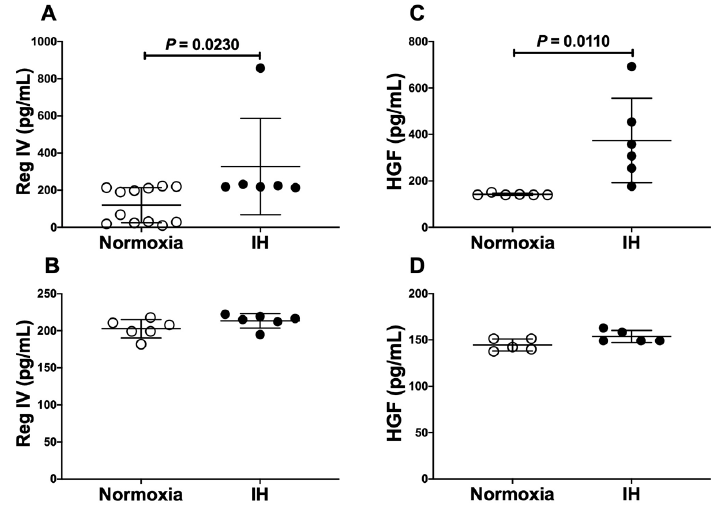
Figure 10. The effects of miR-499 mimic transfection on Reg IV and Hgf expression. Concentrations of medium Reg IV and Hgf were measured by ELISA as described in the Materials and Methods section. The figure represents ( A ) Reg IV expression in miR-499 mimic NC-introduced cells, ( B ) Reg IV expression in miR-499 mimic-introduced cells, ( C ) Hgf expression in miR-499 mimic NC-introduced cells, and ( D ) Hgf expression in miR-499 mimic-introduced cells. Data are expressed as mean ± SD for each group. The statistical analyses were performed using Student’s t -test.